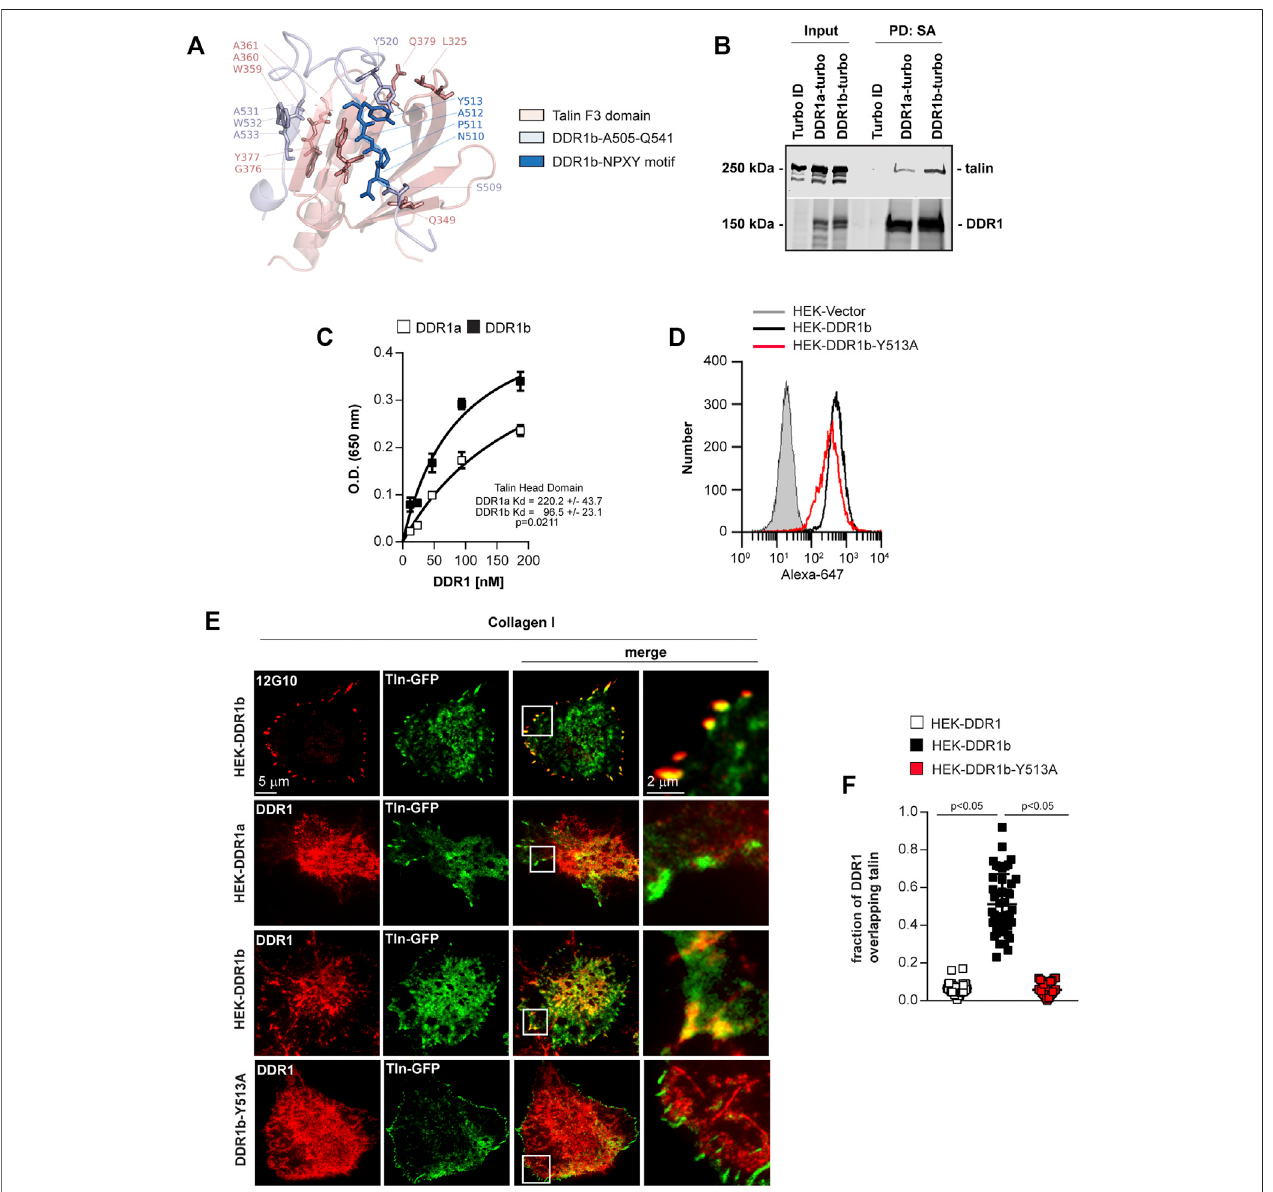
FIGURE4| TalinbindsbettertoDDR1bthanDDR1a. (A) ModelofbindingbetweenDDR1bintracellulardomain(A505-Q541)andtalinF3domain.TalinF3domain isinpink,DDR1bA505-Q541isinlightblueandtheNPxYmotifofDDR1bishighlightedindarkblue.Sidechainsoftheaminoacidsdiscussedintexthavebeenshownin sticks. (B) TurboID,DDR1a-turboorDDR1b-turboHEKexpressingcellswereplatedoncollagenI(30 μ g/ml)for1 – 3 handthenlysedandsubjectedtoStreptavidin(SA) pull-down (PD) followed by western blotting with talin or DDR1 antibodies. (C) Immobilized talin head domain (3 µg/ml) was incubated with increasing amounts of puri fi ed cytoplasmic domains of DDR1a or DDR1b and the bound DDR1 was detected with anti-DDR1 antibody. Raw data in C were fi tted with Non Linear Regression – Global Curve Fitting with one site saturation using Sigma Plot and the calculated Kd were compared using a two-tailed t -test. (D) HEK cells were stable transfectedwitheitheremptyvector,DDR1borHEK-DDR1b-Y513AcDNAsandcellpopulationsexpressingcomparablelevelsofDDR1weresortedbyFACS. (E) Total internalre fl ection fl uorescence(TIRF)microscopyofHEK-DDR1a,HEK-DDR1bandDDR1b-Y513Acellsstabletransfectedwithfulllengthtalin1-GFPplatedoncollagen I (20 µg/ml)for 1 h and then stained withanti-DDR1 or12G10 antibody. Overlay images revealco-localization of12G10 and talin (positive control) and DDR1bwith talin. (F) Co-localization of DDR1a, DDR1b and DDR1b-Y513A with talin1-GFP at the cell membrane of cells plated on collagen I was determined using the ImageJ/JACoP analysis and the Manders ’ overlap coef fi cient (Bolte and Cordelieres, 2006). Values are the mean ± SEM of 3-4 FAs analyzed in more than 10 cells and represent the fraction of DDR1 signal overlapping with talin-GFP signal. Statistical analysis: one-way ANOVA followed by Tukey ’ s multiple comparisons test.